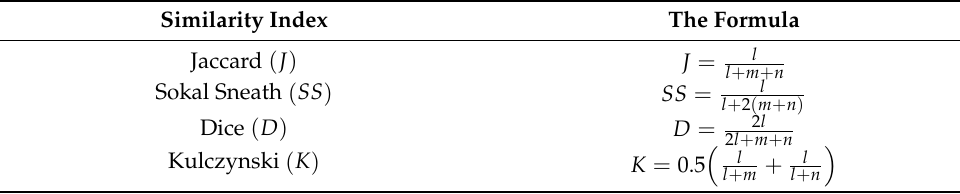
Table 3. Similarity indices used in the current study.